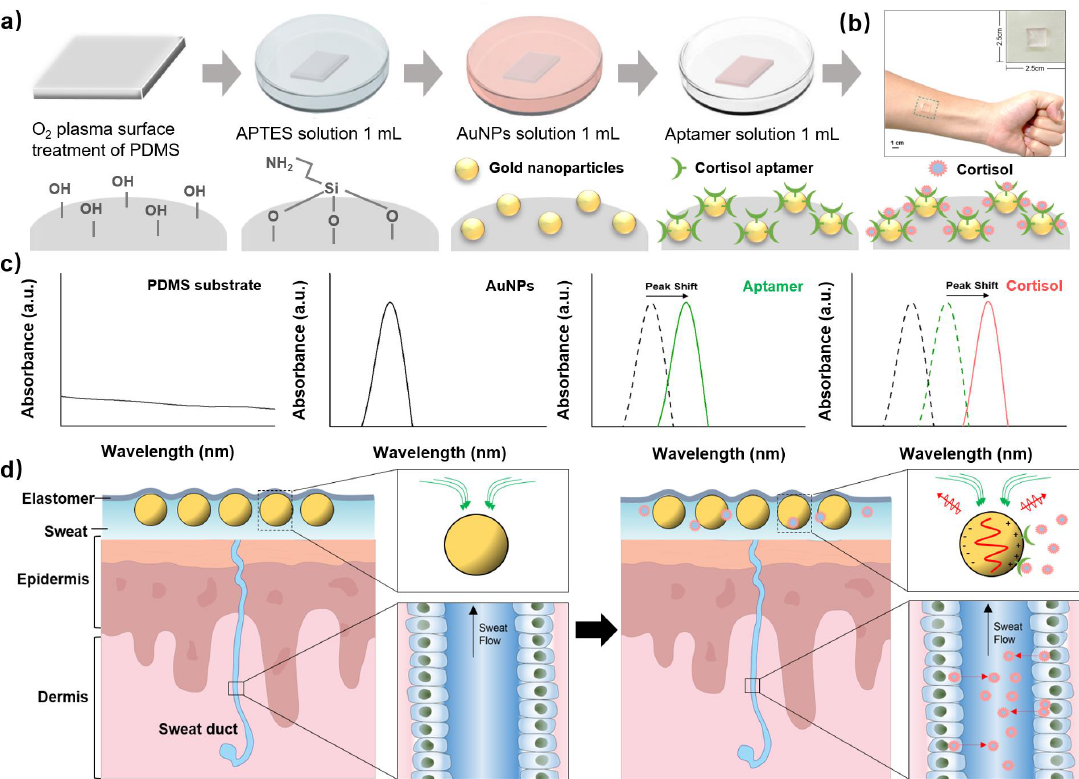
Figure 1. Schematic of the wearable sweat biosensor. ( a ) Fabrication process, ( b ) optical photography ( c ) reaction mechanism, and ( d ) structure of the human sweat gland showing the flexible LSPR biosensor interaction in the skin cross-section.